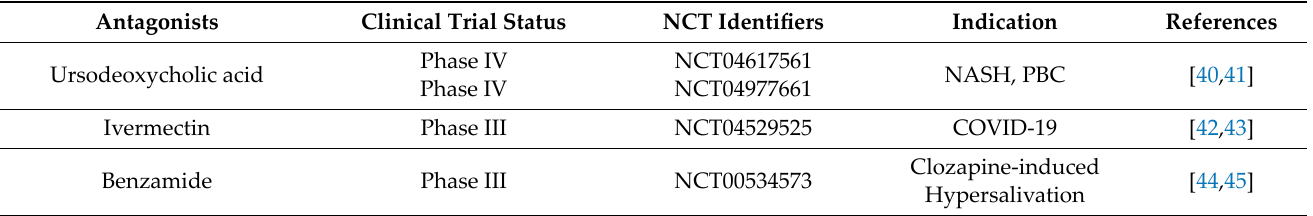
Table 3. FXR antagonist clinical